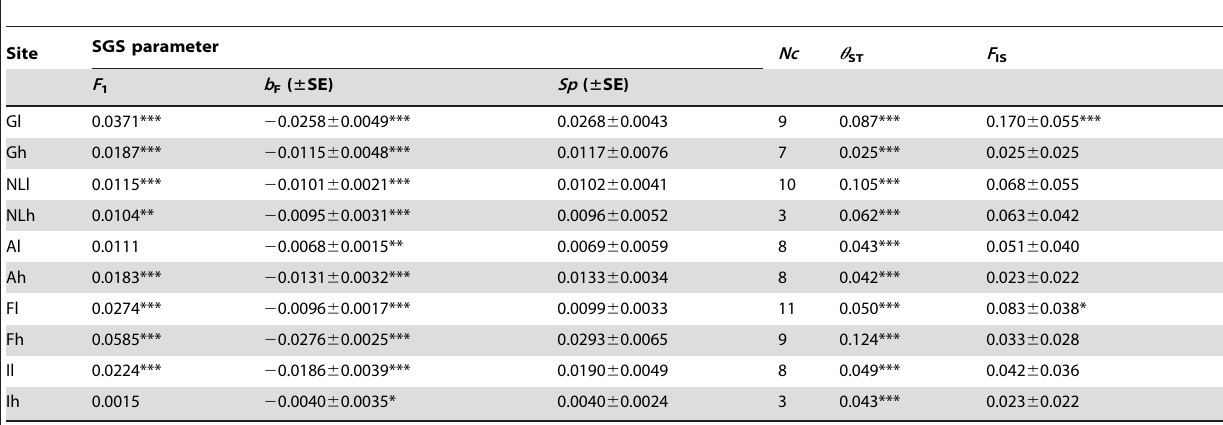
Table 2. Parameters describing within-population genetic structure in the studied beech plots.